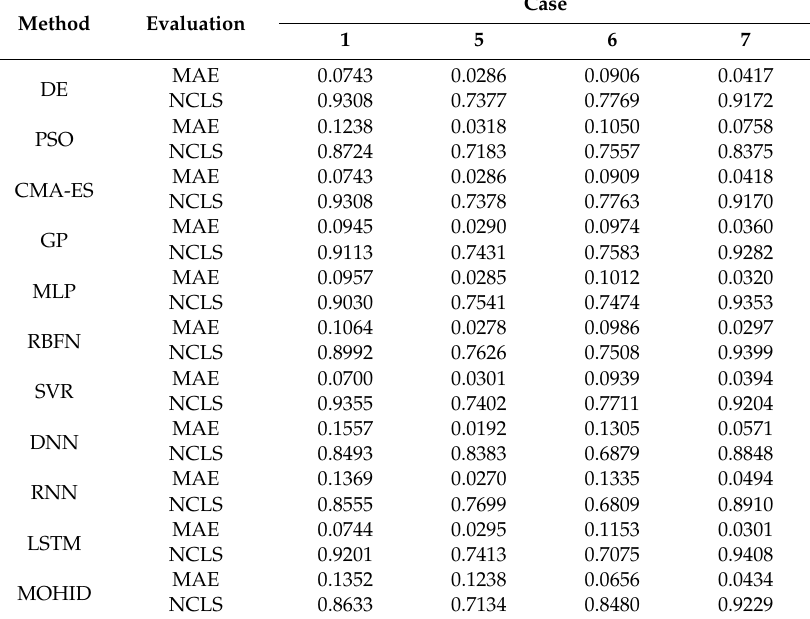
Table 6. Results for Seosan